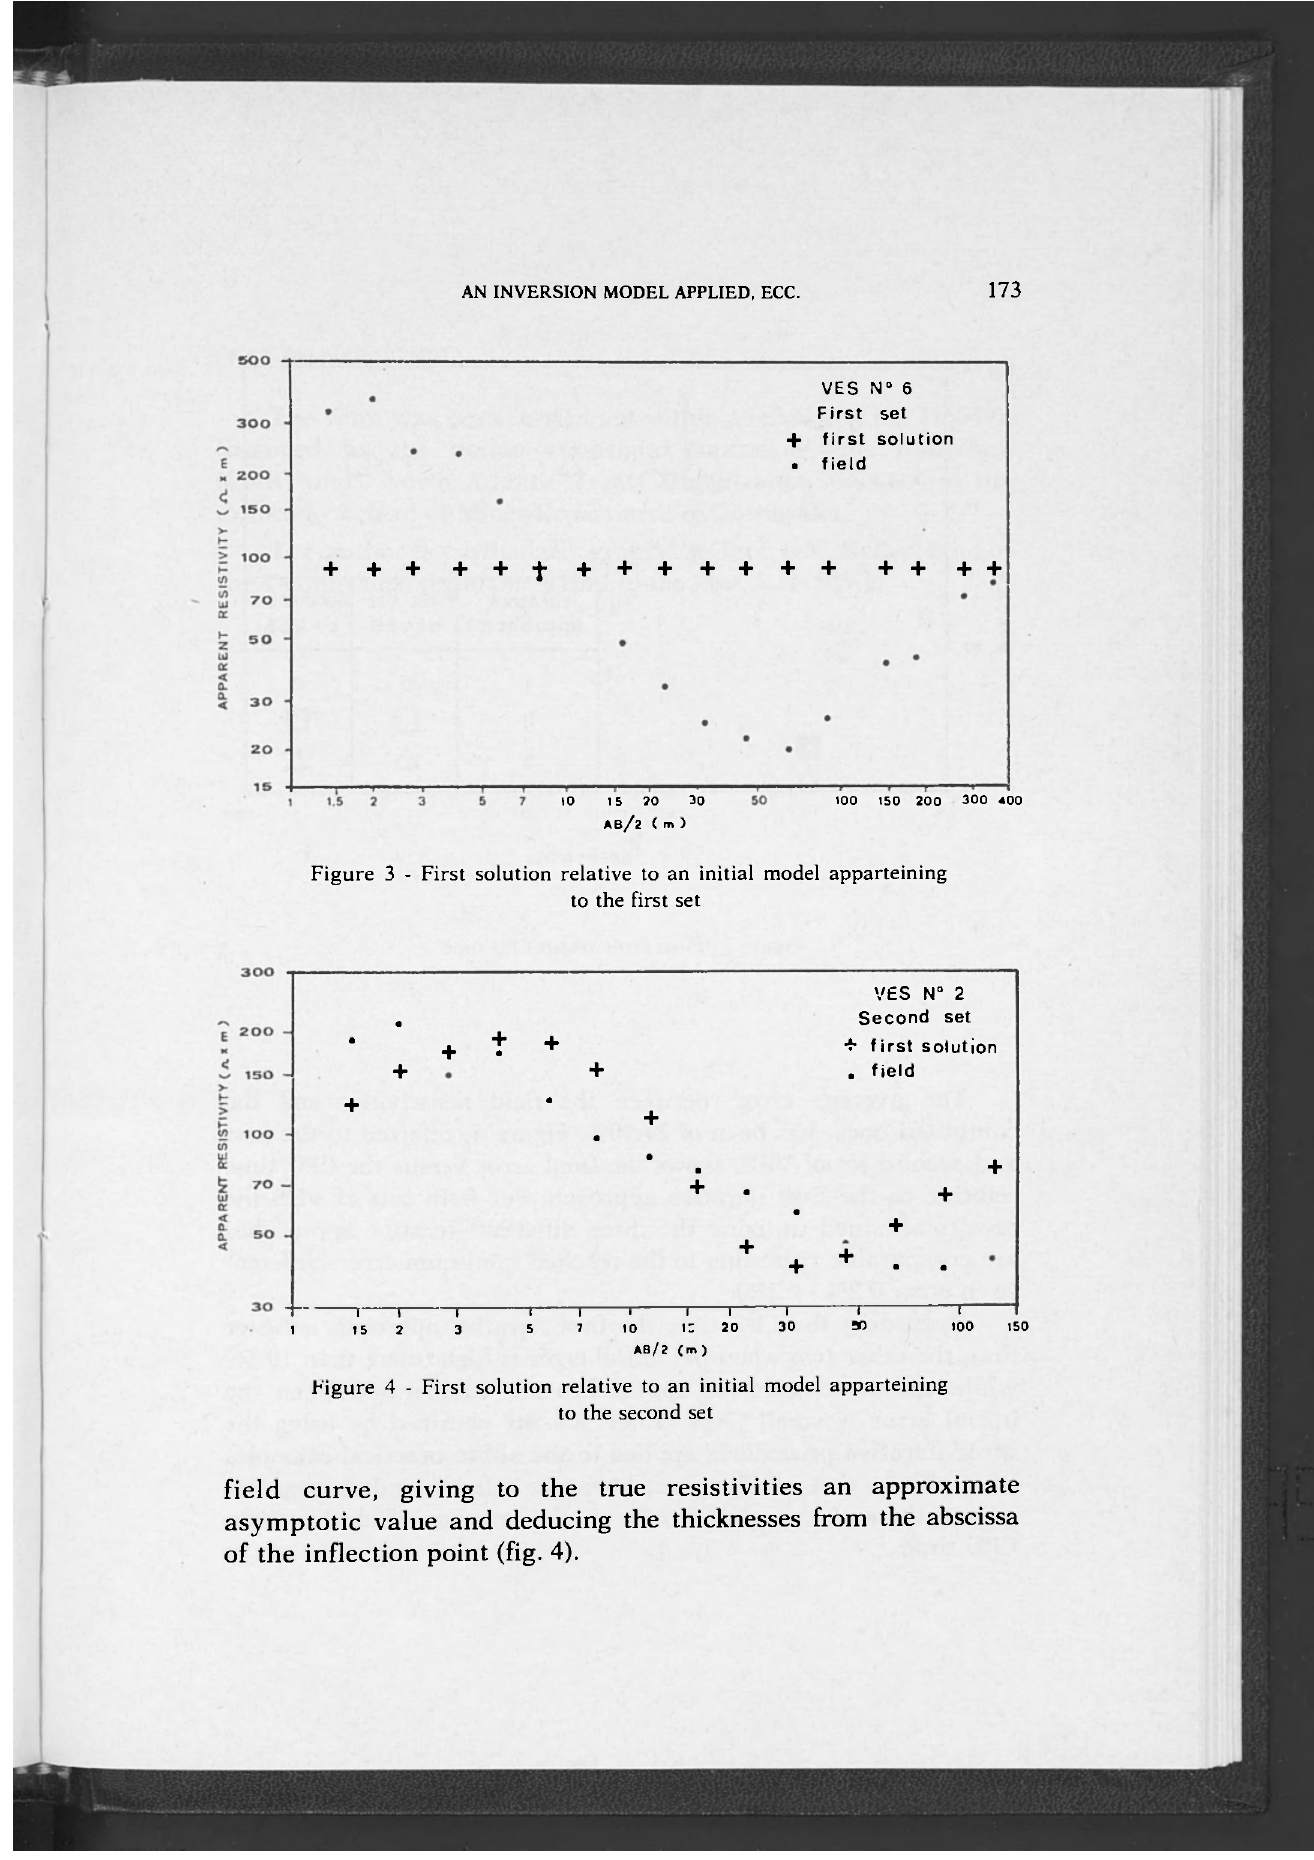
AN INVERSION MODEL APPLIED, ECC. 173